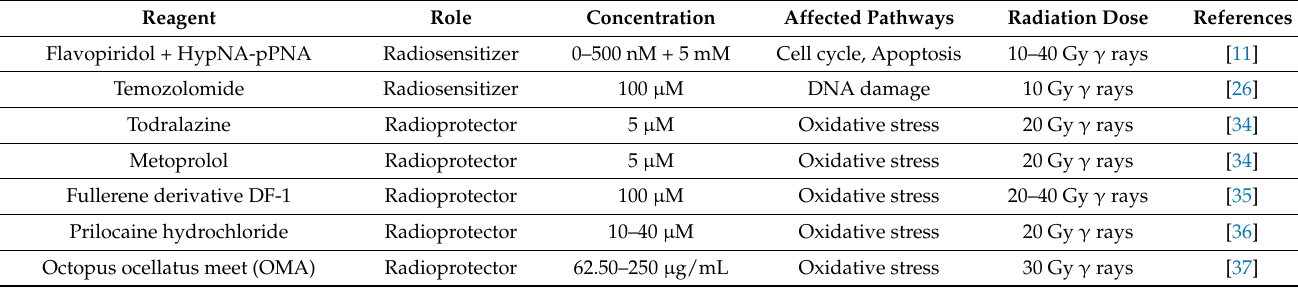
Table 1. Summary of the experimental conditions and effects observed using the radiomodifying agents described in this review. Each column, from left to right, highlights the following aspects: reagent name, reagent role (either radioprotector or radiosensitizer), concentration used, molecular pathway affected, radiation dose used, and references. * In this case, no concentration values are indicated because the reagent used was either a genetic mutation (radiosensitizing mutation 7) or a knocked-down gene